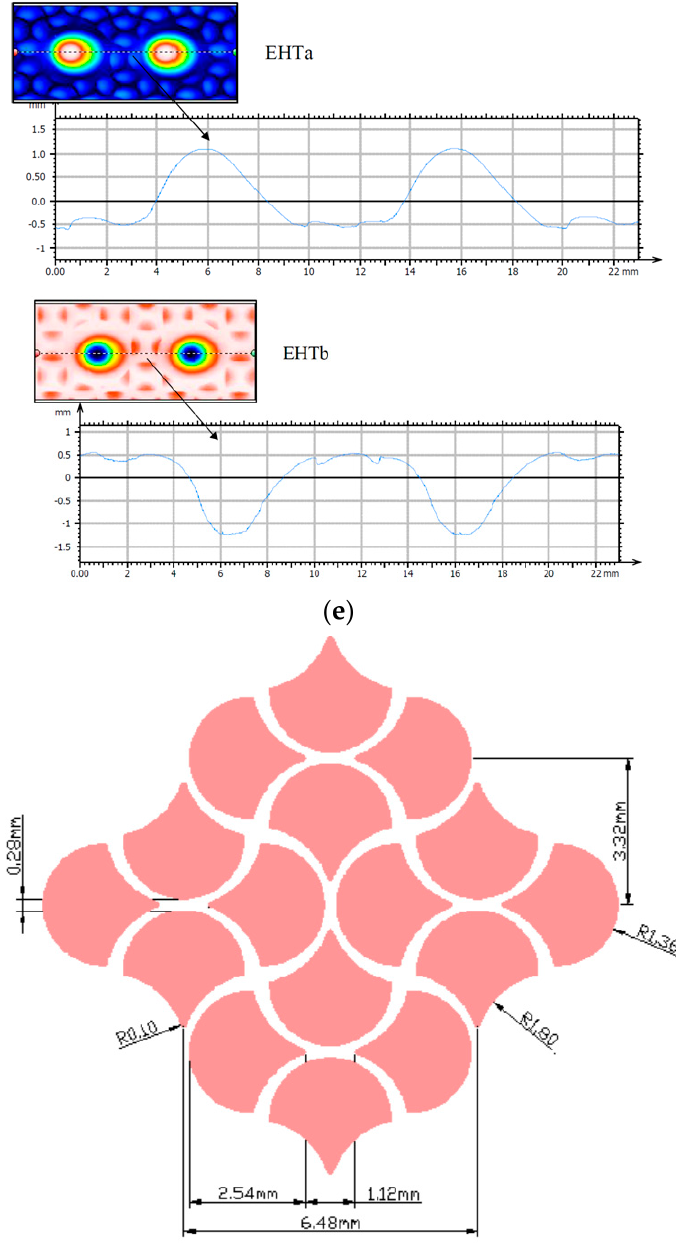
Figure 2. Surface enhancement pattern profiles and details for the following surfaces ( a ) Hydrophobic pattern (HY), ( b ) Herringbone pattern (HB), ( c ) Herringbone/Dimple pattern (HB/D), ( d ) Helical grooved pattern (HX), ( e ) EHT, and ( f ) details of the petal-shaped background pattern used in the EHT surface. Table 1. Physical measurements of the enhancement patterns used in the various tubes.